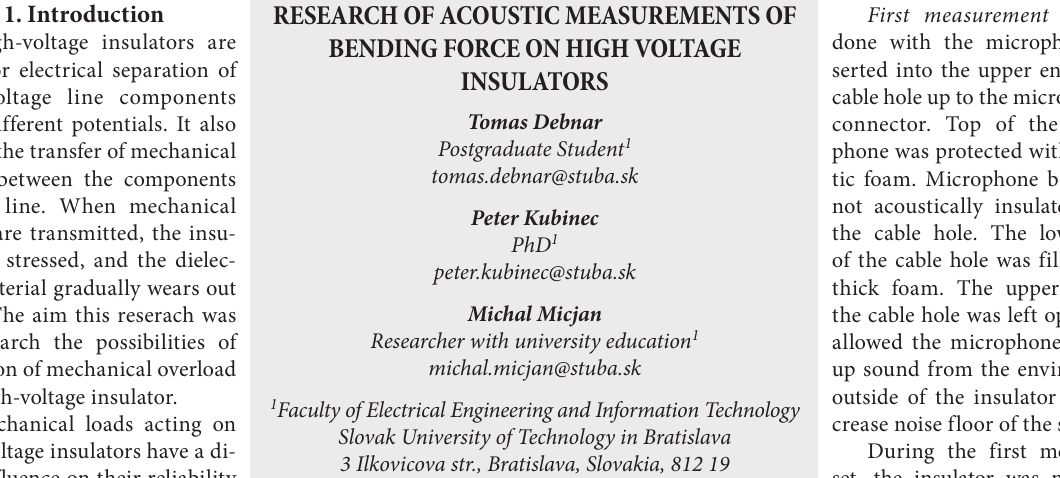
impulse responses and on Fig. 2